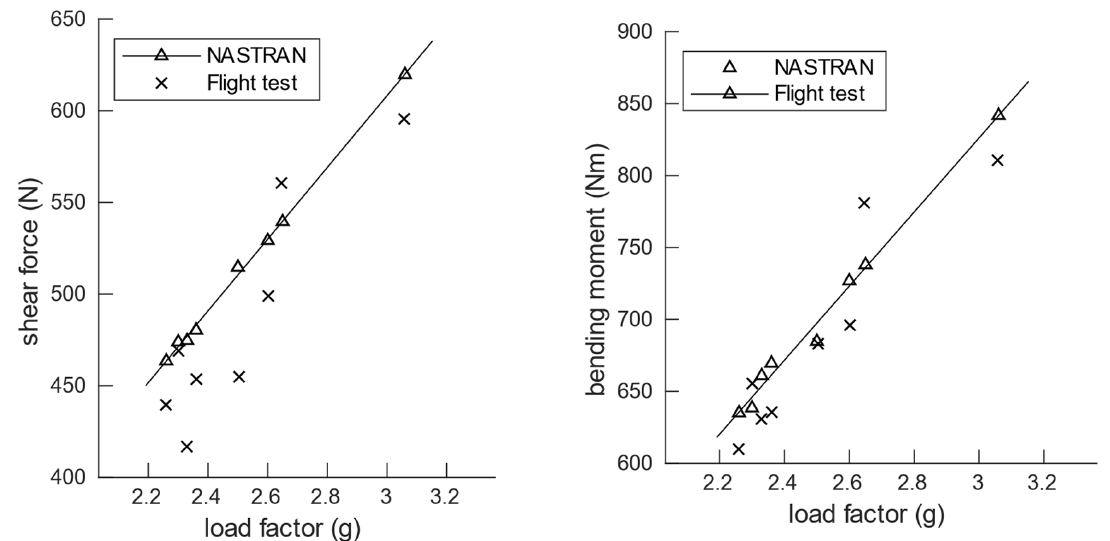
Figure 18. Shear force and bending moment (at wing root—span location 0.108 m) at different flight test manoeuvres for the reference wing.